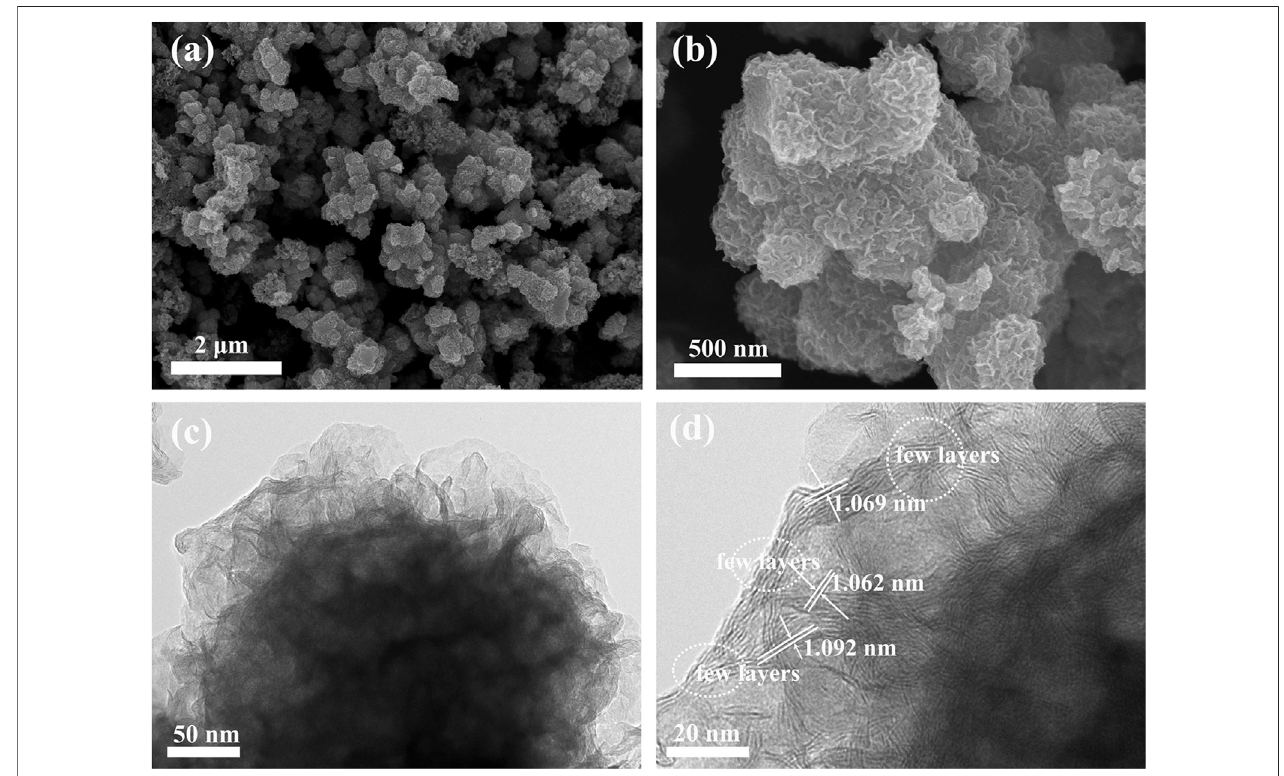
FIGURE 4 | FESEM images (A,B) , TEM (C) and high-resolution TEM (D) images of F-MoS 2 @NC-0.8.